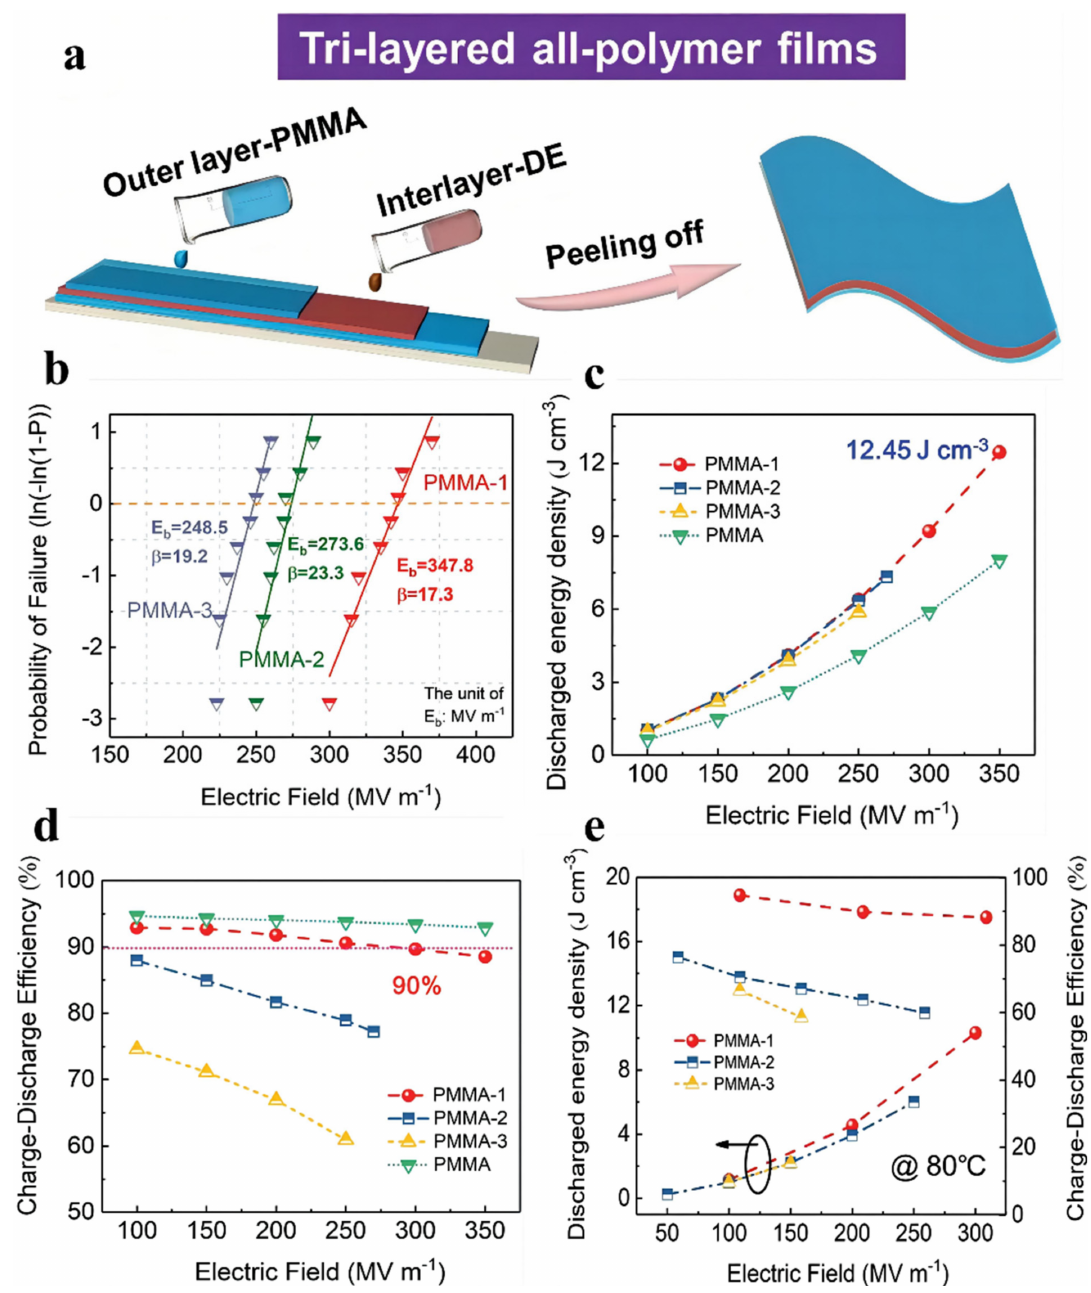
Figure 8. ( a ) Schematic of the preparation process via the layer-by-layer solution casting process. ( b ) Weibull breakdown field distribution. ( c ) Discharged energy density, ( d ) charge-discharge effi- ciency under varied electric fields of the tri-layered all-polymer composites. ( e ) Comparison of the at 80 ◦ C. Adapted with permission from [40], Copyright © 2022 Royal Society of